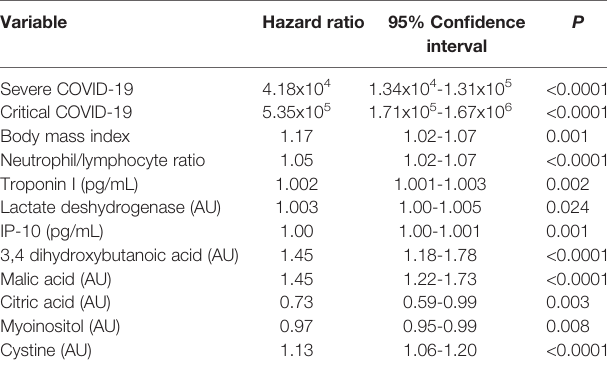
TABLE 6 | Multivariate Cox regression model to predict the risk of the development of adverse outcomes (progression and death) in patients with COVID-19.